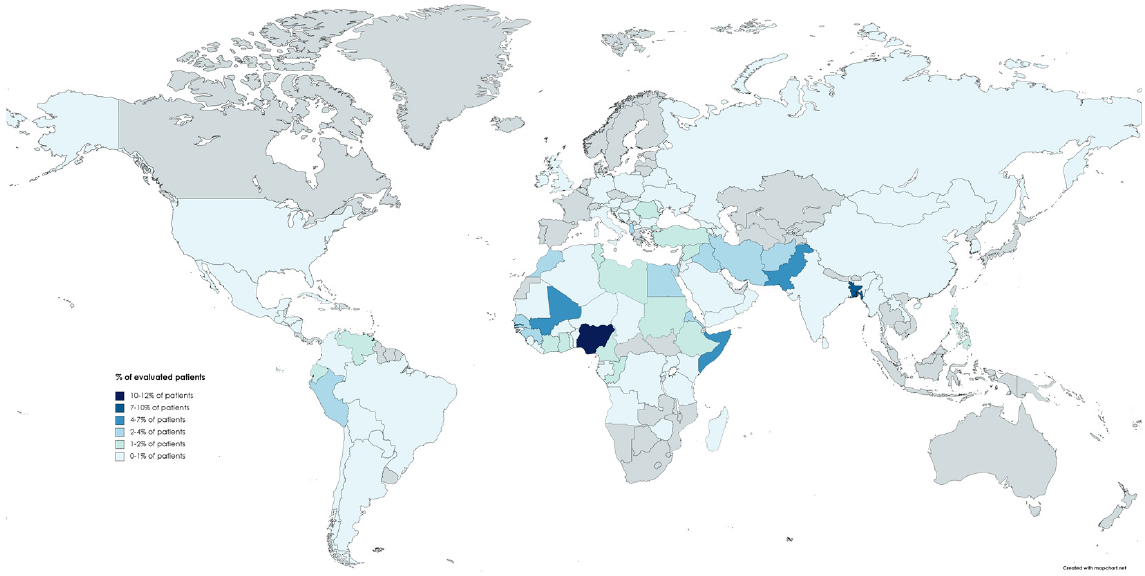
Figure 1. World map representing the geographical origin of the screened subjects. Of note, 10.3% of the screened migrants were Nigerians, 7.6% Bangladeshi and 5.6% Pakistani.